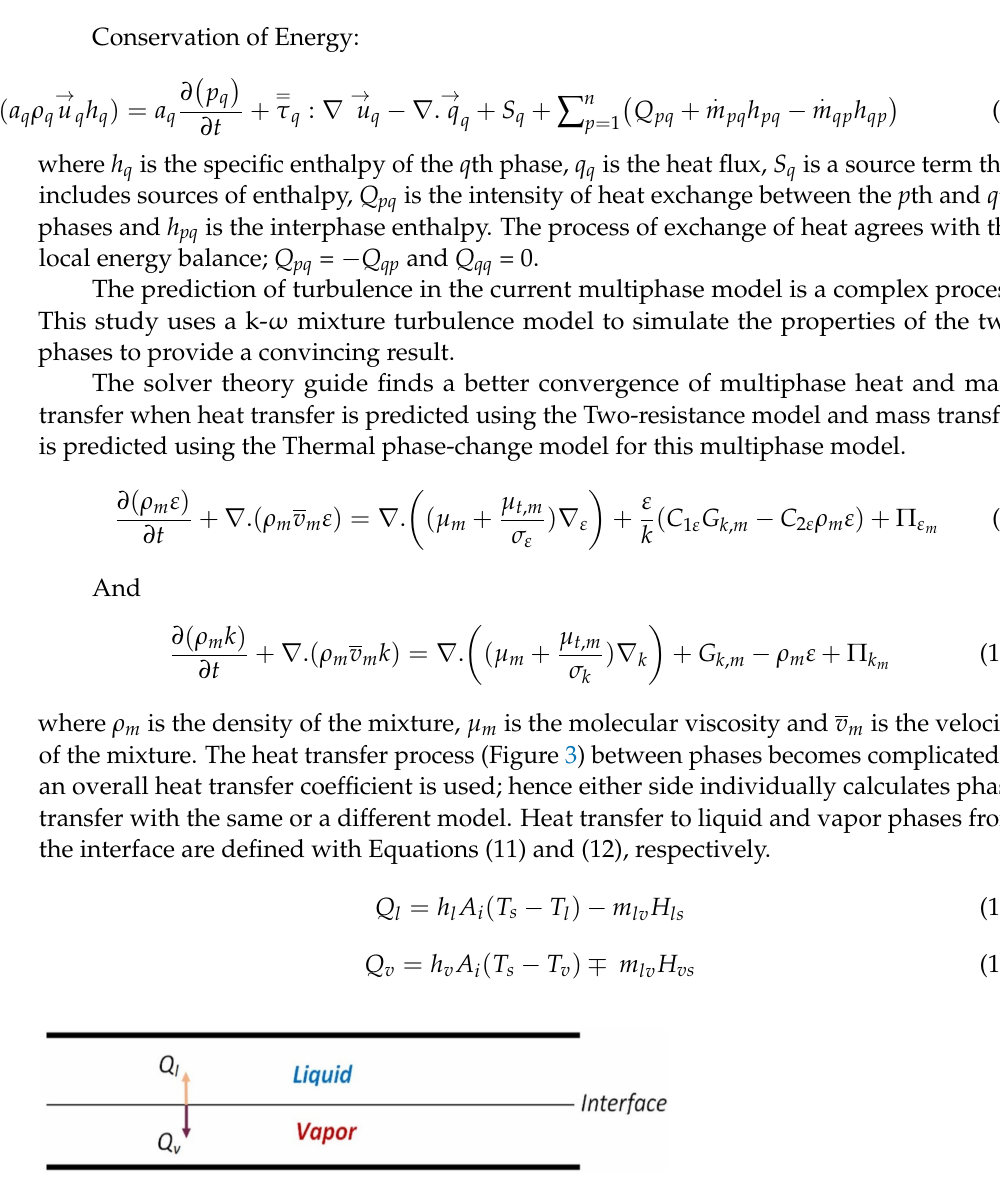
Figure 3. Interphase heat and mass